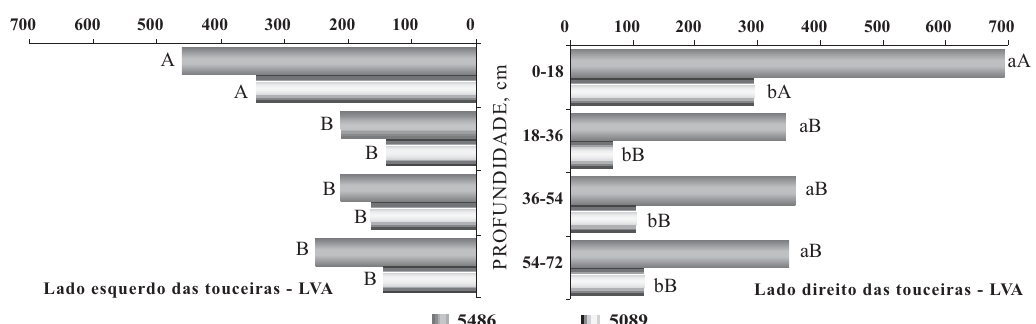
Figura 7. Comprimento radicular de soqueiras de cana-de-açúcar em profundidade no perfil do LVA. Letras minúsculas comparam cultivares dentro de cada profundidade. Letras maiúsculas comparam cada cultivar em relação às quatro profundidades pela Diferença Mínima Significativa (DMS) a 5